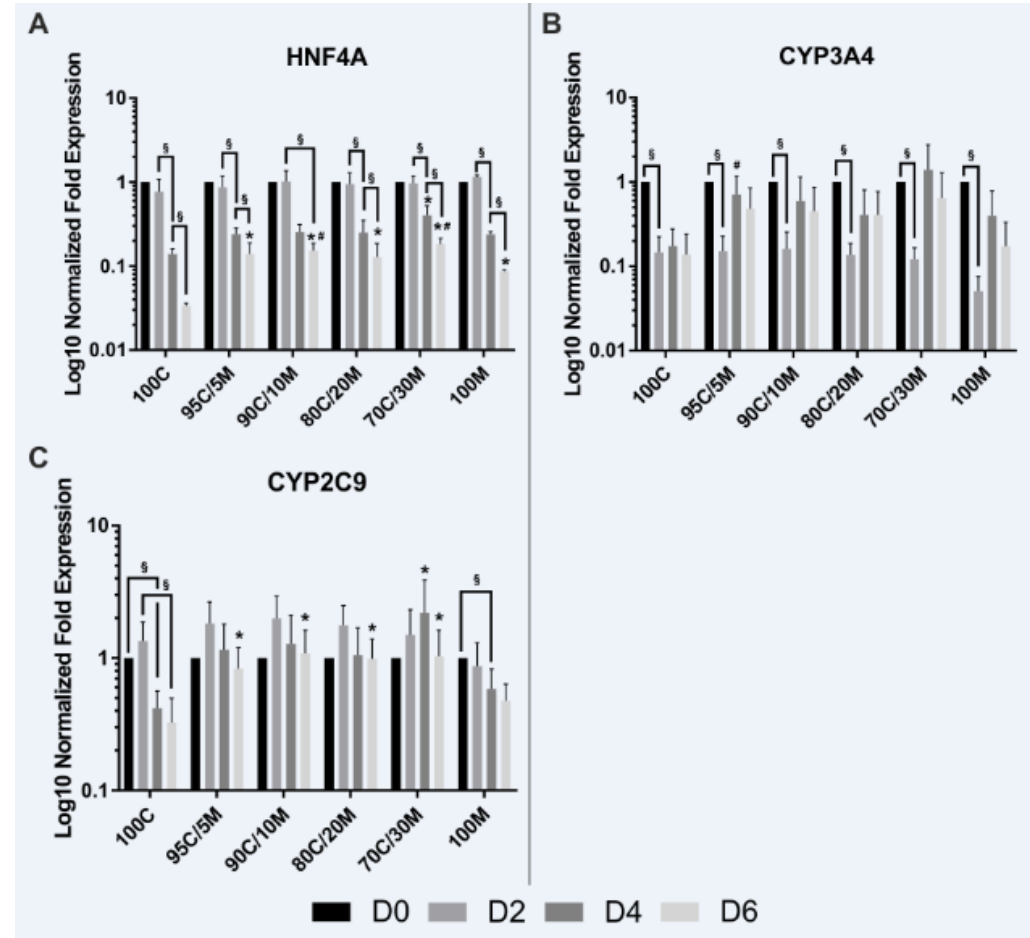
Figure 3: Gene expression of HNF4A and its downstream targets in primary human hepatocytes (PHHs) in monolayer cultures (MCs) on different extracellular matrices (ECMs). PHHs were cultured for up to 6 days on pure collagen type I (100C), on ECMs based on collagen type I (C), supplemented with ascend- ing percentages of Matrigel (M): 95C/5M, 90C/10M, 80C/20M, 70C/30M or on pure Matrigel (100M). Messenger RNA levels of (A) HNF4A (hepatocyte nuclear factor 4 alpha), (B) CYP3A4 (cytochrome P450 family 3 subfamily A member 4) and (C) CYP2C9 (cytochrome P450 family 2 subfamily C member 9) were determined by RT-qPCR. Fold gene expressions were normalized to day 0 of each cultivation type. Data are shown as the mean of normalized fold gene expressions + SEM on a log10-scale, n = 3, two-way ANOVA and Bonferroni correction for multiple testing, statistics were performed on ΔCT values, statistical significance was assumed at p ≤ 0.0332. Significant differences between PHHs cultured on one of the various matrices in comparison to PHHs cultured on 100C of the same day are marked with *. Significant differences between PHHs cultured on one of the various matrices in comparison to PHHs cultured on 100M of the same day are marked with #. Significant differences observed at different time points of PHHs cultured on the same ECM are marked with §. Selected comparisons are shown; for details on the statistical evaluation, see Supplementary Table 1C, supplementary